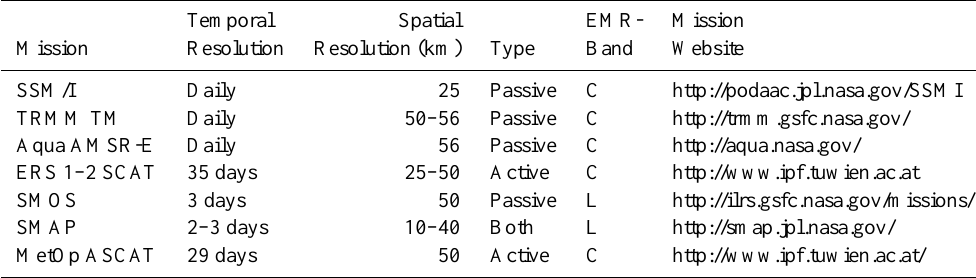
Table 1. Synopsis of recent and future satellite soil moisture missions. Temporal Spatial